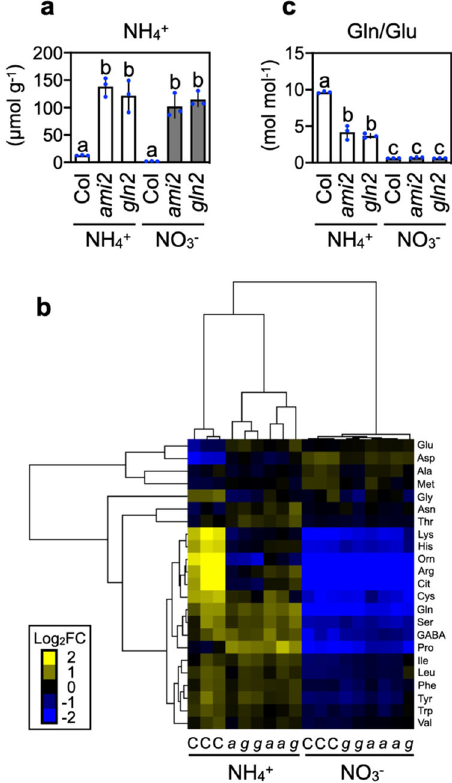
Fig. 4 Lowered activity of GLN2 reduces the conversion of ammonium to amino acids. a The shoot ammonium content of 12-d-old Col, ami2 , and gln2 5 d after transfer to media containing 10 mM ammonium or 10 mM nitrate (mean ± SD; n = 3). Three shoots from one plate constituted a single biological replicate. b Hierarchical clustering of the shoot amino acid content of 12-d-old Col (C), ami2 ( a ), and gln2 ( g ) 5 d after transfer to media containing 10 mM ammonium or 10 mM nitrate. The color spectrum from yellow to blue corresponds to the relative content of each amino acid. The fold-change (FC) value on each amino acid was calculated by dividing the amino acid content of a sample by the mean content of all 18 samples. Log 2 FC denotes the base-2 logarithm of FC. c The molar ratio of Gln to Glu in the shoots of 12-d-old Col, ami2 , and gln2 5 d after transfer to media containing 10 mM ammonium or 10 mM nitrate (mean ± SD; n = 3). a , c Different letters denote signi fi cant differences at P < 0.05 (Tukey – Kramer ’ s multiple comparison test). b , c Six shoots from two plates constituted a single biological replicate. Three biological replicates were sampled separately three